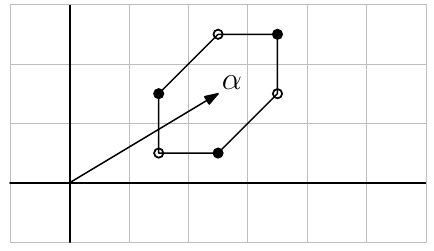
Figure 7. hexagon factor from (5.22).